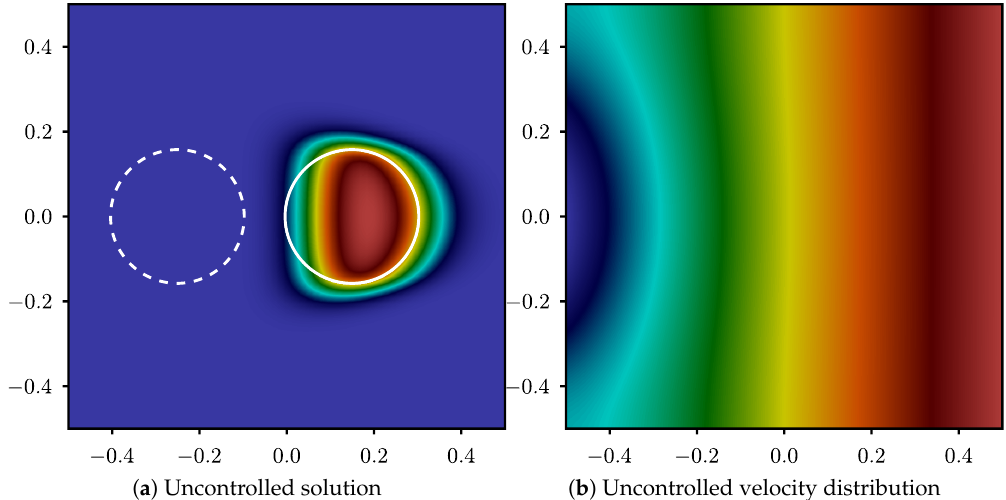
Figure 5. Volume fraction and velocity potential of the uncontrolled solution: The dashed circle represents the initial location of the interface and the solid circle represents the desired interface location at T =